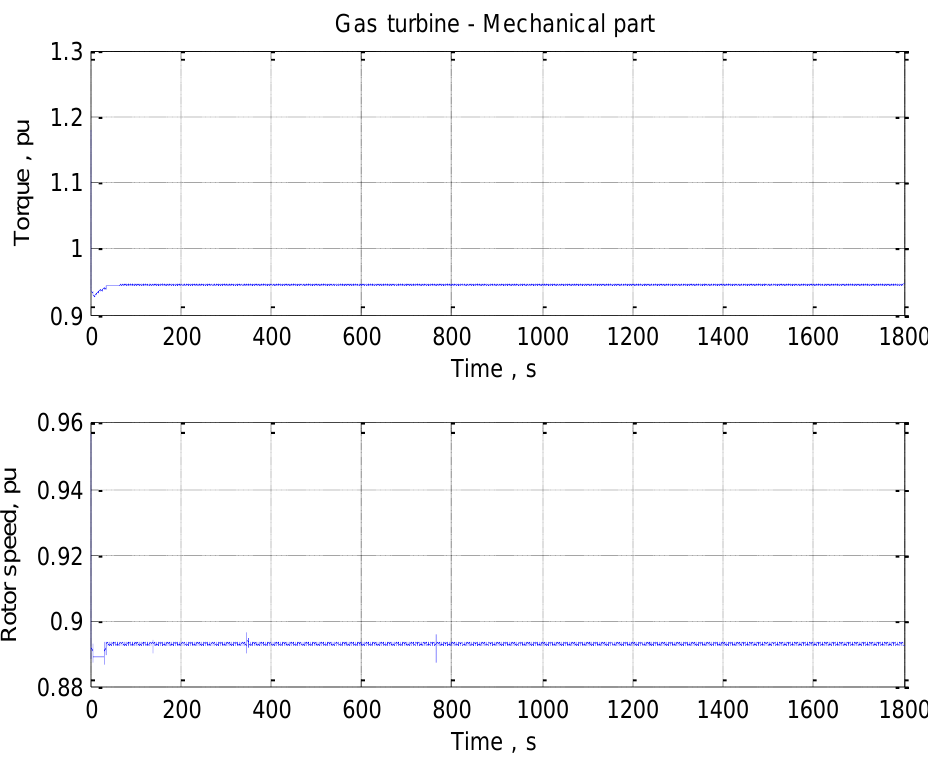
Figure 12. Mechanical characteristics of the turbine.